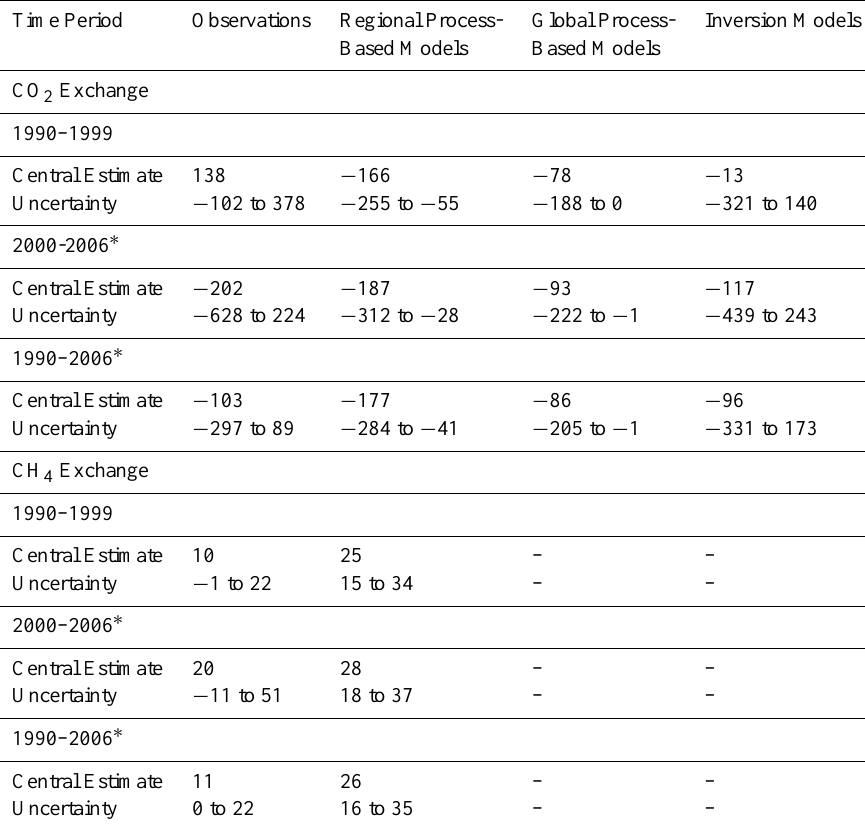
Table 10. Comparison of estimates of mean net CO 2 -C and CH 4 -C exchange from arctic tundra to the atmosphere (TgCyr − 1 ) among observations, process-based models, and inversion